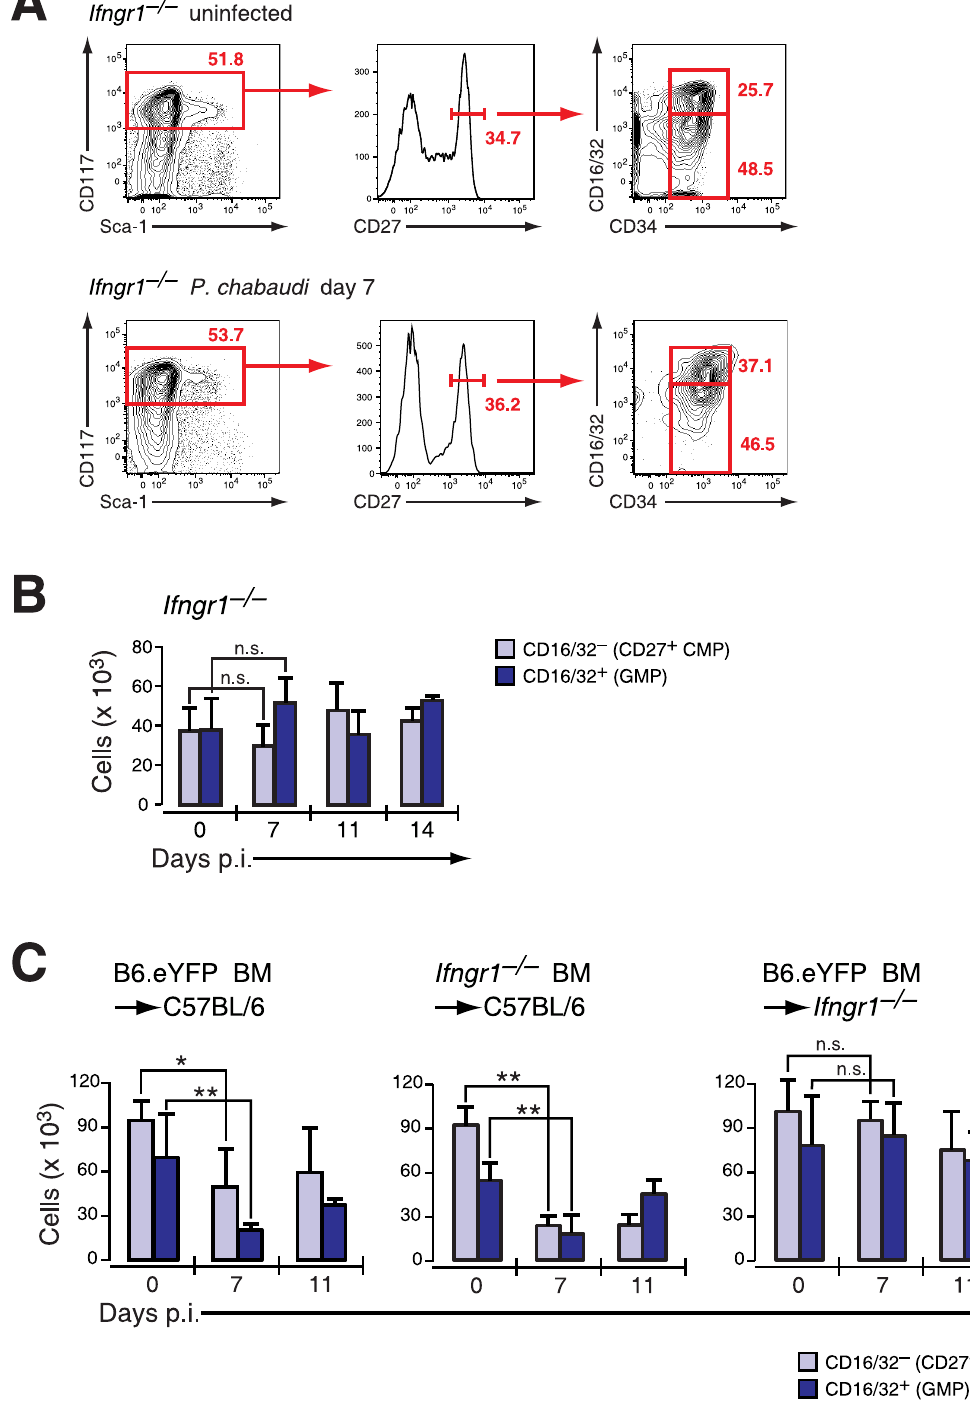
Figure 4. Infection-induced decrease of early myeloid progenitors is critically dependent on IFN- c signaling. A. Phenotype of LIN 2 BM cells in Ifngr1 -null mice uninfected and at day 7 after infection with P. chabaudi stained for indicated marker. Representative FACS plots of four experiments with each 5 mice per group are shown. B. Absolute numbers (per femur/pair) for Ifngr1 -null LIN 2 c-Kit hi CD27 + cells are shown as mean 6 SEM per individual subsets obtained form three experiments with 5–6 mice per group (n.s.: P . 0.05, Mann-Whitney U-test). C. Absolute numbers of myeloid progenitors in radiation chimeras (Hosts: C57BL/6, left and middle; Ifngr1 -null, right chart) reconstituted either with B6.Rosa26 eYFP or Ifngr1 - null and 8–9 weeks after transplantation infected with P. chabaudi . Two different sets of chimeras were infected and 5–9 animals per time point each were analyzed. Data represent mean 6 SEM of cell number per femur/pair (*: P # 0.05; **: P # 0.01, Mann-Whitney U-test).